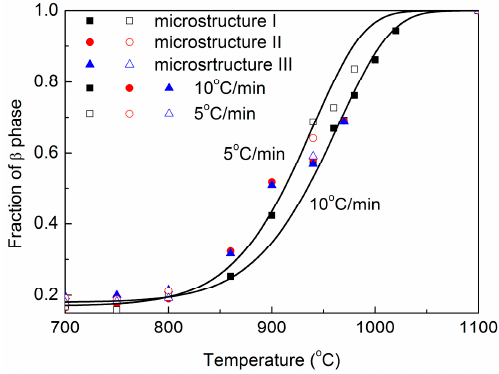
Figure 9. Measured fraction β with temperature at different heating rates. Metals 2017 , 7 , 200